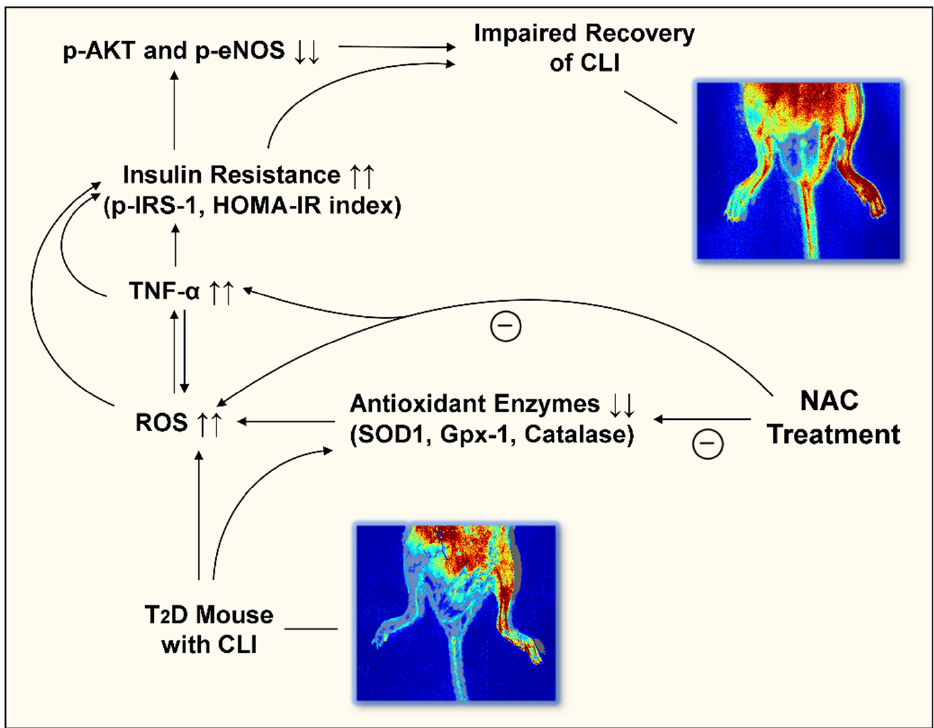
Figure 8. Illustration of potential mechanisms for the beneficial effects of NAC on the recovery of CLI in T2D mice. We proposed that NAC enhances the recovery of CLI in T2D mice through multiple mechanisms: (1) attenuation of excessive ROS production; (2) reduction of plasma TNF- α level; (3) decrease of insulin resistance (evidenced by increased levels of p-IRS-1 and the HOMA-IR index) in ischemic limbs; and (4) preservation of the expressions of antioxidant enzymes, phosphorylated IRS-1, Akt, and eNOS. CLI, Critical limb ischemia; T2D, type-2 diabetes; NAC, N-acetylcysteine; ROS, reactive oxygen species; SOD-1, copper-zine superoxide dismutase in cytoplasm; Gpx-1, glu- tathione peroxidase-1; HOMA-IR, homeostatic model assessment of insulin resistance; -, inhibit; ↑ , increase; ↓ , decrease.